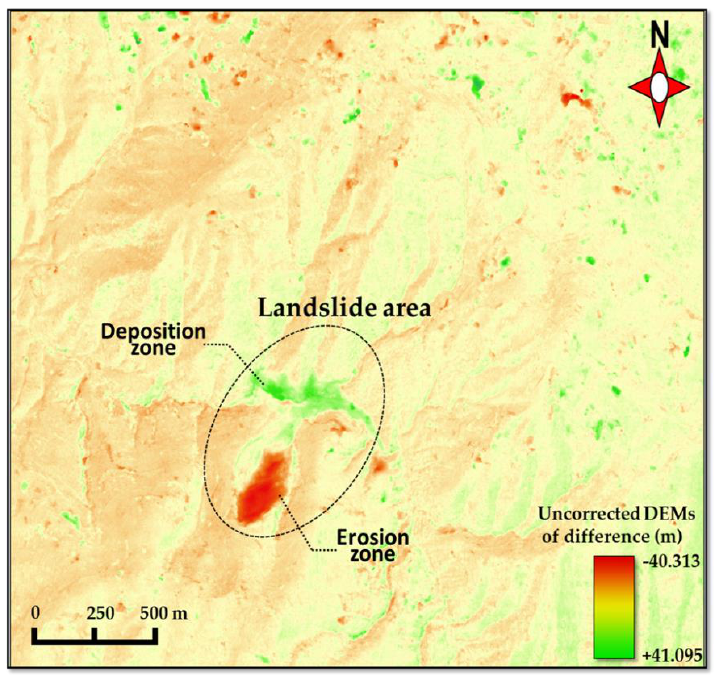
Figure 5. Uncorrected DEMs of difference (DoD) obtained from the pixel-based change detection using the pre-and post-event DEMs.